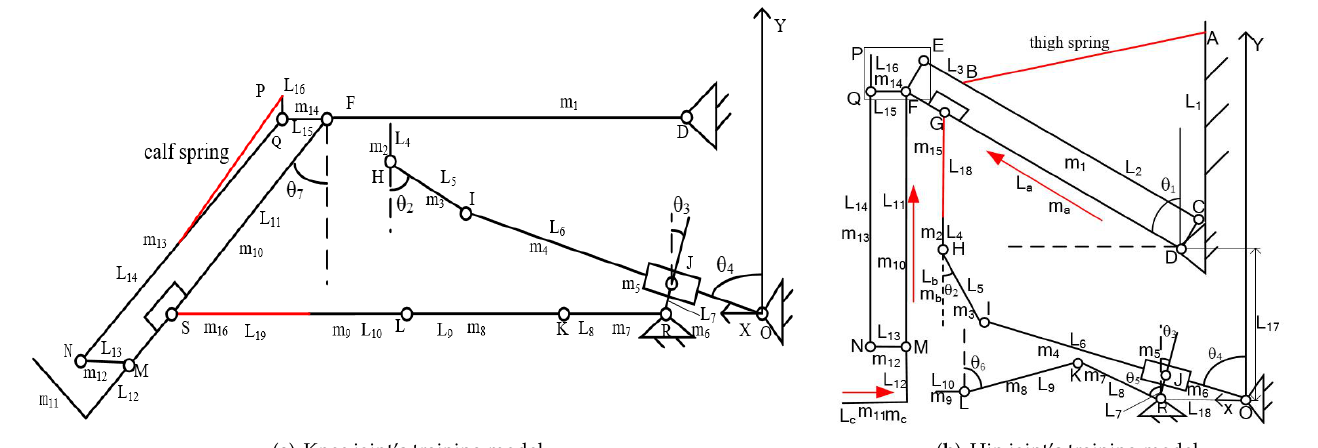
Figure 7. Rehabilitation training model of knee and hip joint.